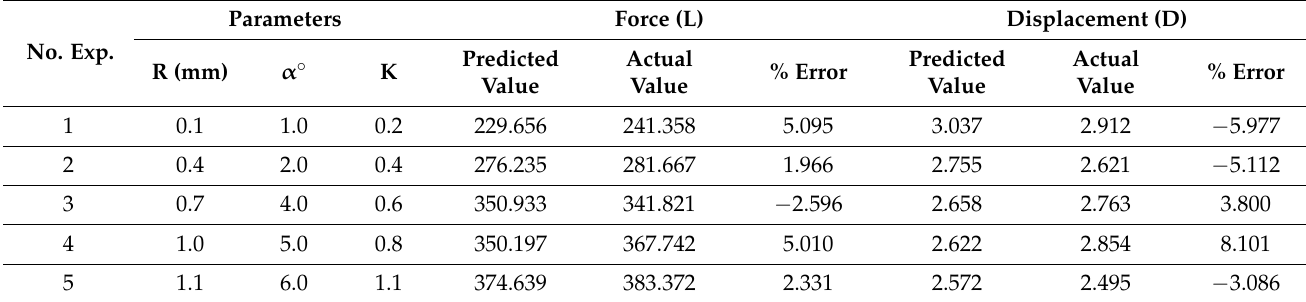
Table 6. Experiments performed to confirm the mathematical values for force (L) and displacement (D) for new parts. Parameters No. Exp. No. Exp.